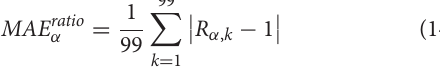
Frontiers in Physics |